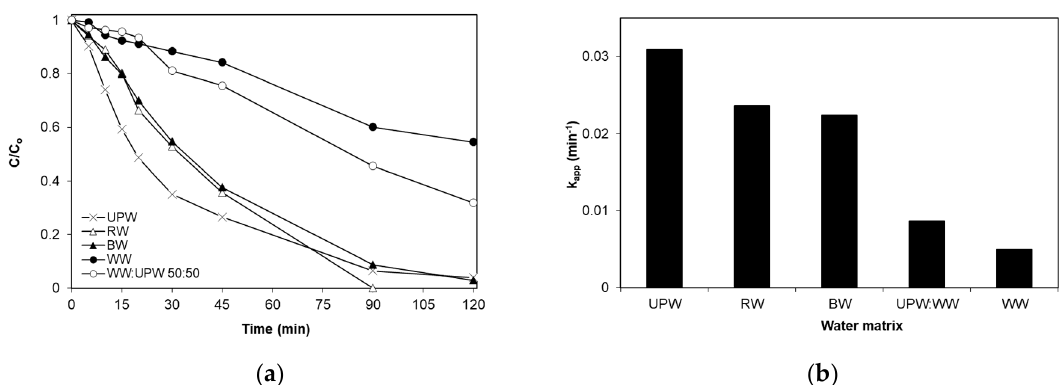
Figure 9. Effect of the water matrix on the photocatalytic degradation of SMX ( a ) and apparent kinetic constants ( b ). [SMX] = 234 μ g/L, [0.04%Fe/TiO 2 ] = 1 g/L and natural pH.